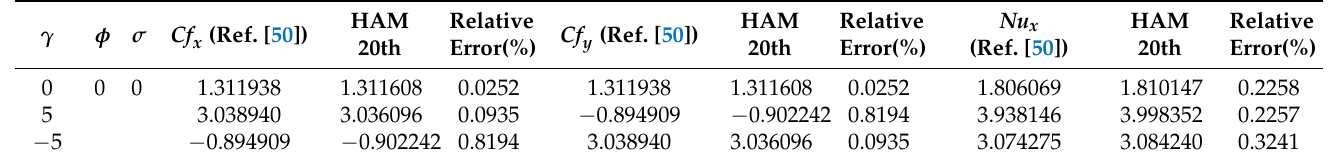
Table 5. Skin friction coefficients of Cf x , Cf y and local Nusselt number Nu x under values of γ , φ , and σ when Pr =